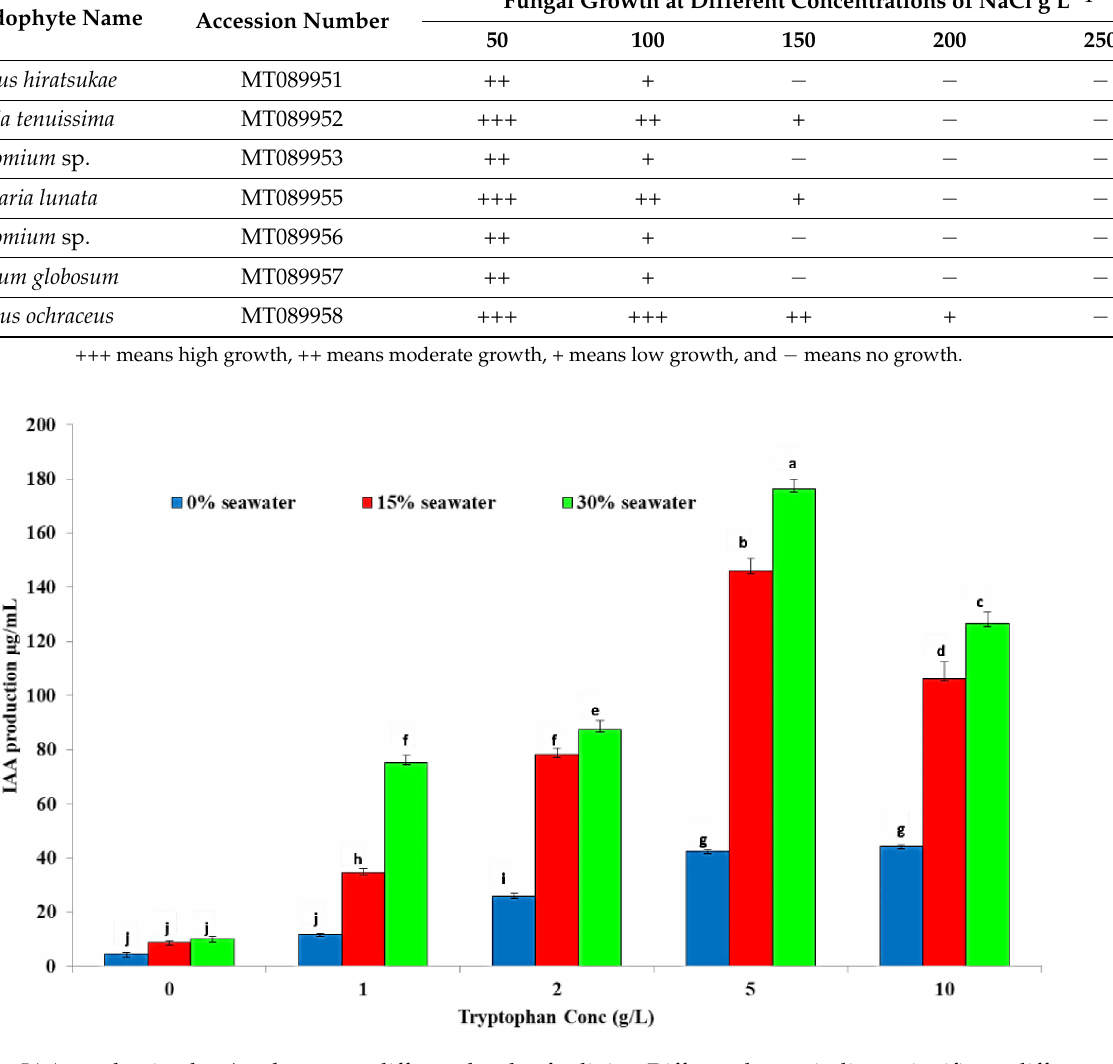
Figure 1. IAA production by A. ochraceus at different levels of salinity. Different letters indicate significant differences between the treatments according to an LSD test at p <